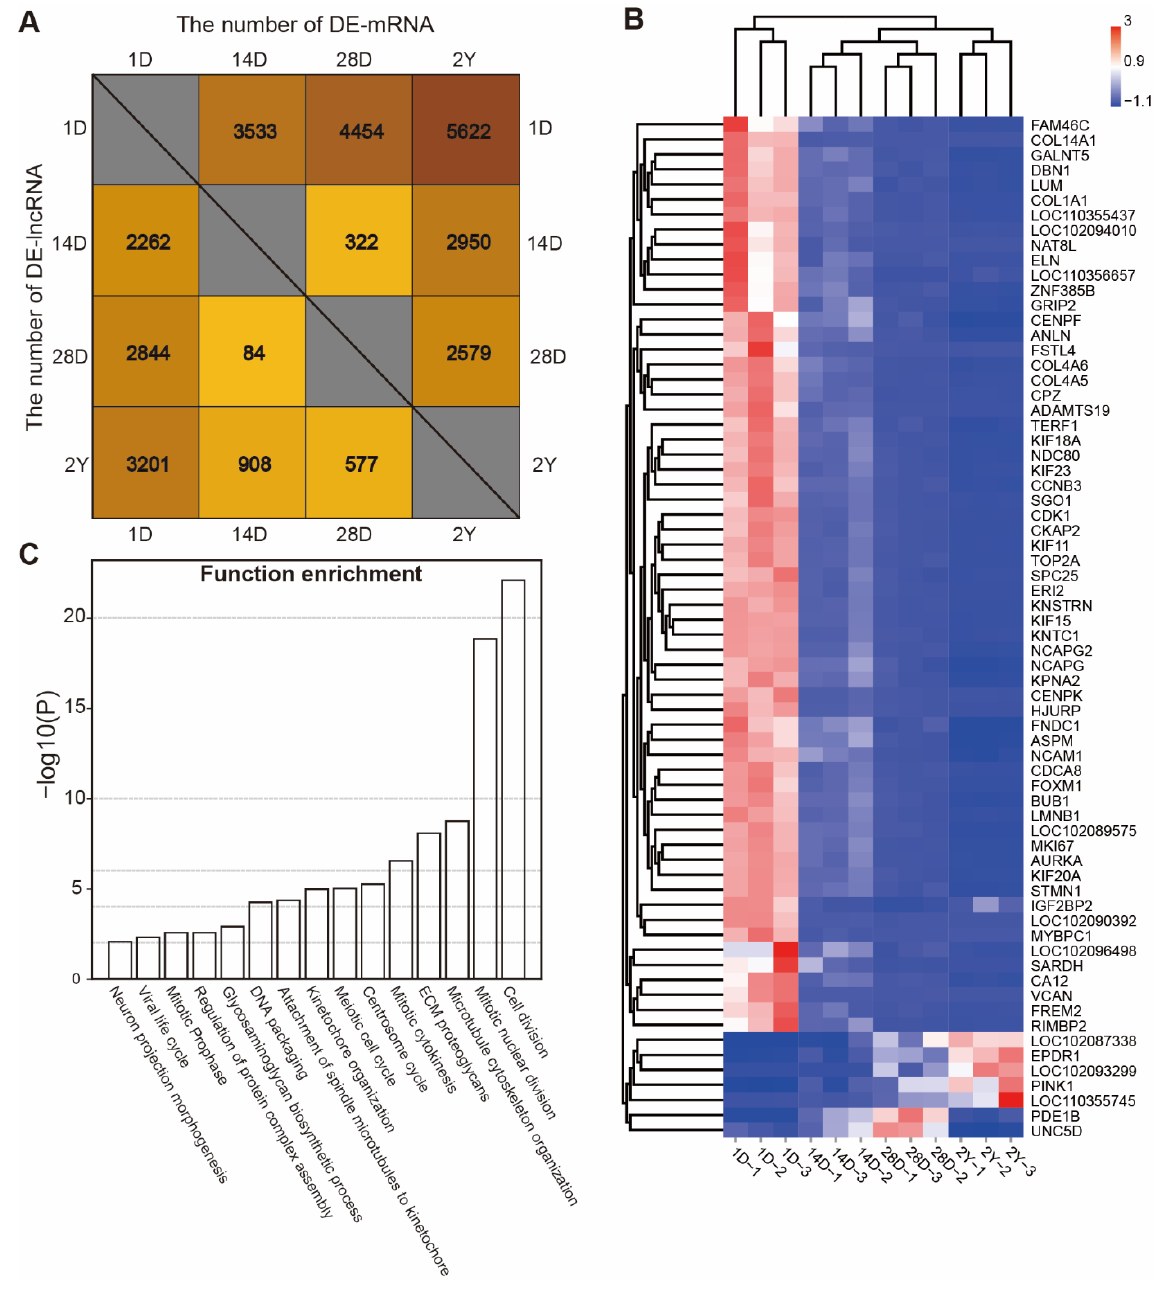
Figure 3. The identification and functional analysis of differently expressed genes. ( A ) The number of DE-mRNAs and DE-lncRNAs between stages (1D versus 14D, 1D versus 28D, 1D versus 2Y, 14D versus 28D, 14D versus 2Y, and 28D versus 2Y). ( B ) The expression heatmap of common differentially expressed mRNAs and lncRNAs. ( C ) The functional enrichment analysis was performed on the down-regulated expression of common DE-mRNAs.